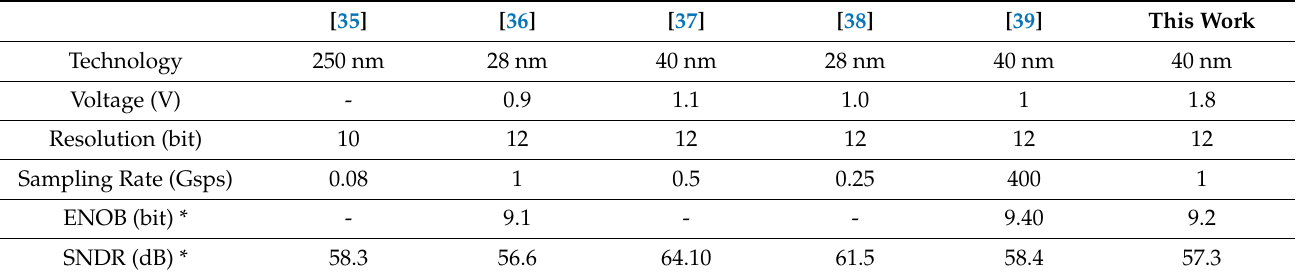
Figure 17. Fast Fourier transform (fft) before and after calibration versus the input frequency 1 GSps . ( a ) fft plot of this ADC versus frequency of the input signal without calibration; ( b ) fft plot of this ADC versus frequency of the input signal with calibration. Table 2. Performance comparison of measured